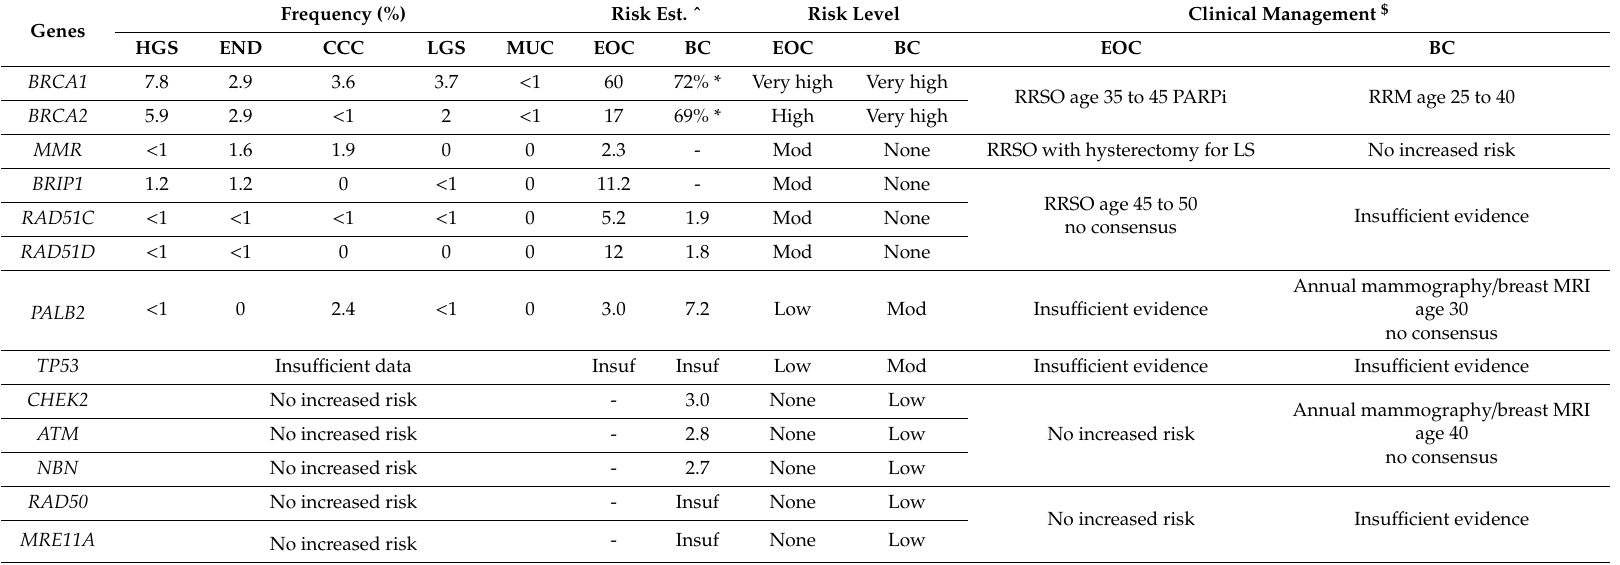
Table 6. Summary of the frequency of deleterious variants by EOC histotype for each homologous recombination (HR) gene and the MMR genes, and a comparison of risk and clinical management for ovarian and breast cancer